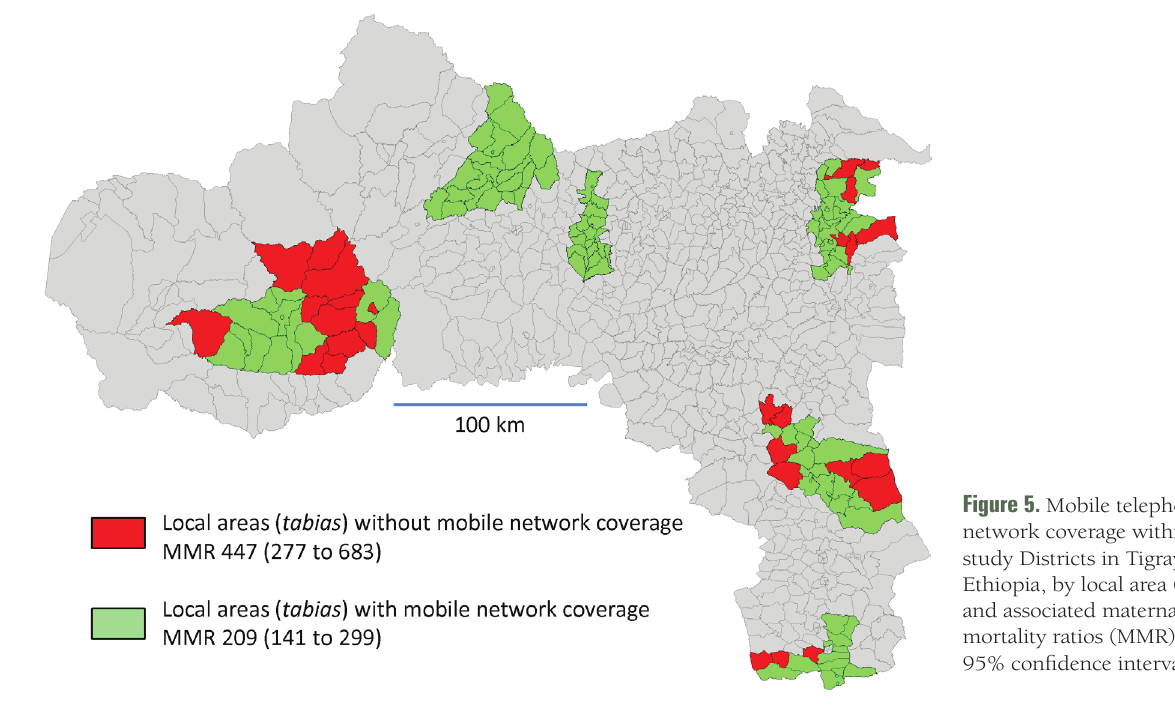
Figure 5. Mobile telephone network coverage within the six study Districts in Tigray Region, Ethiopia, by local area ( tabia ) and associated maternal mortality ratios (MMR) with 95% confidence